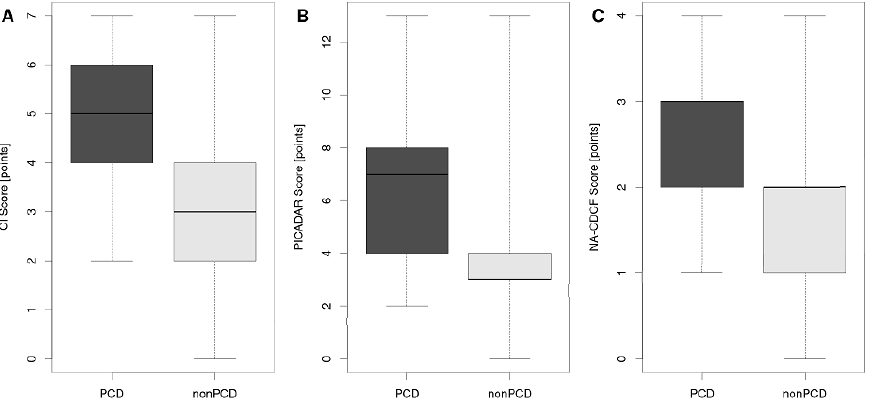
Figure 2. Median calculated values of CI ( A ), PICADAR ( B ), and NA-CDCF ( C ) in PCD and non-PCD patients. The box is drawn from the first to the third quartile with a horizontal line drawn in the middle to denote the median. Whiskers indicate the range of the data.